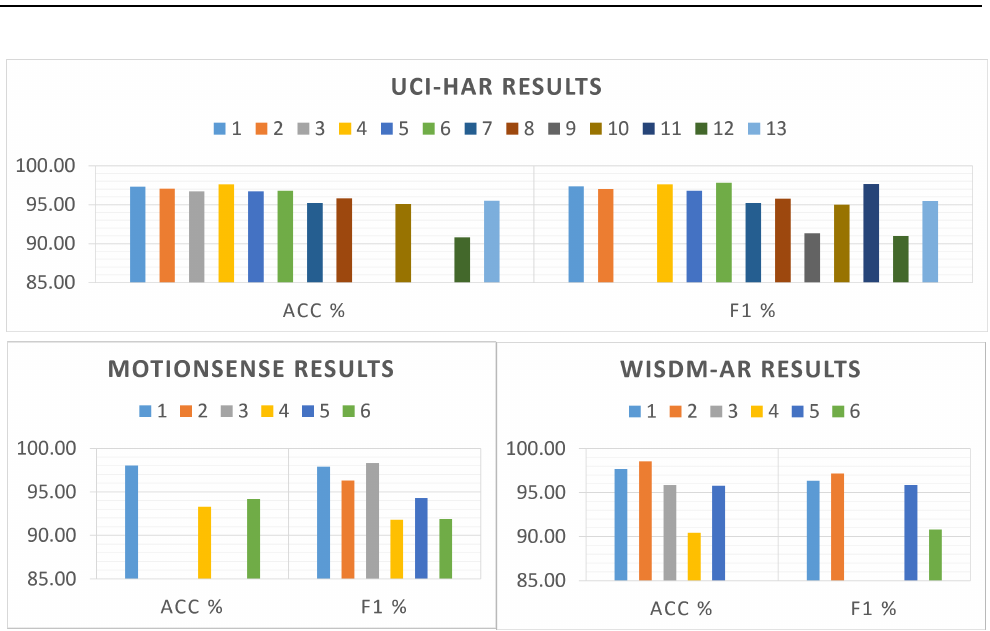
Figure 9. Comparing the proposed model accuracy and F 1 score with related